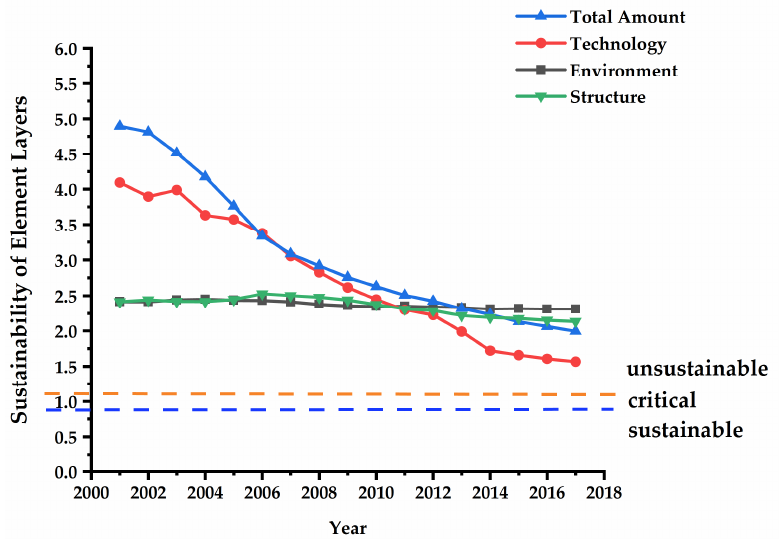
Figure 11. The sustainability of the element layers of China’s power supply and demand system.